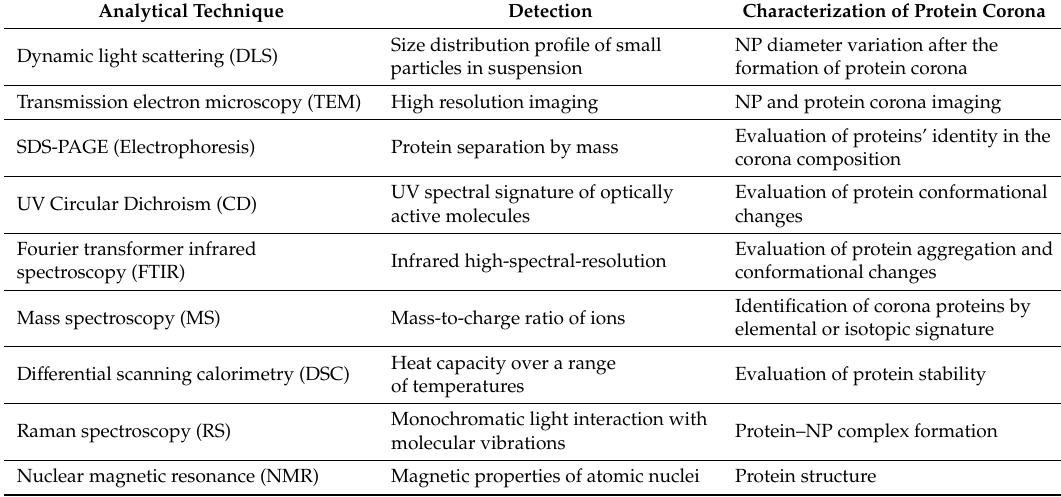
Table 1. The main techniques used to study protein corona